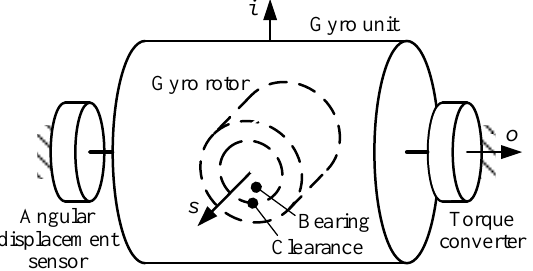
Figure 1. The schematic structure of the gas-dynamic bearing gyroscope.